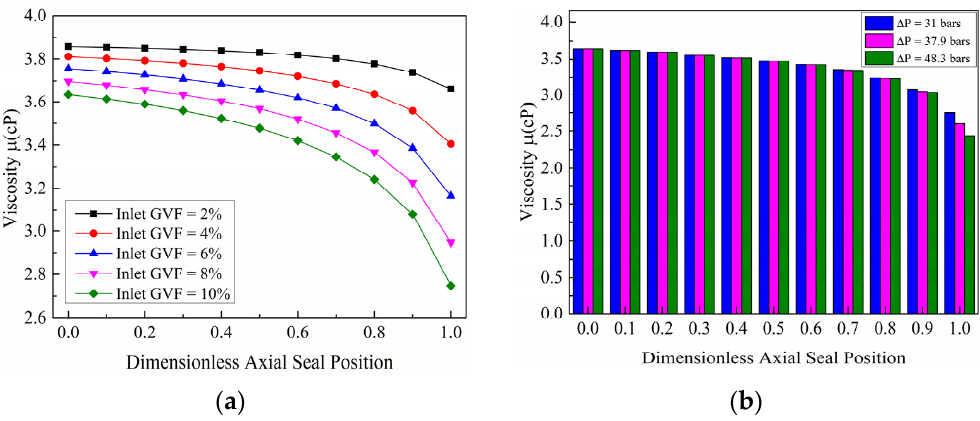
Figure 7. Mixture viscosity along the axial direction under different conditions. ( a ) Under different inlet GVFs with a constant Δ P of 31 bars, ( b ) under different pressure differences with a constant inlet GVF of 10%.